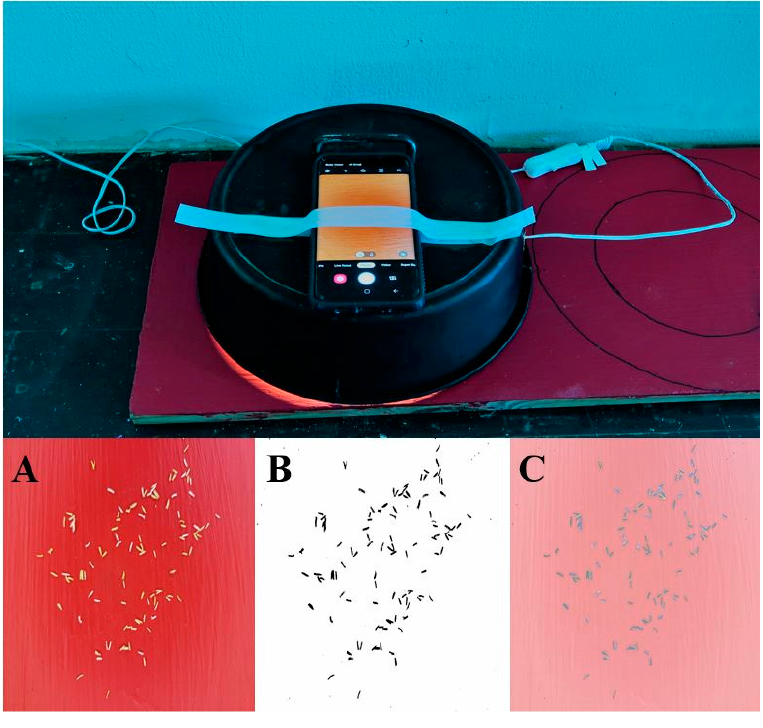
Figure 1. The imaging device used for image capture (A) original image, (B) area of detected anthers, and (C) an overlay of the two images.